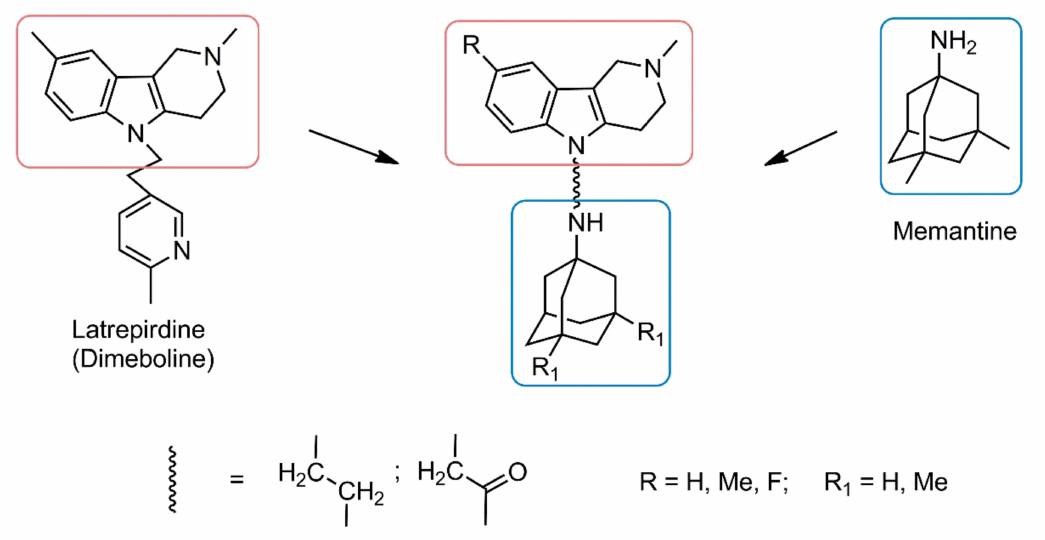
Figure 1. Design of aminoadamantane– γ -carboline conjugates.